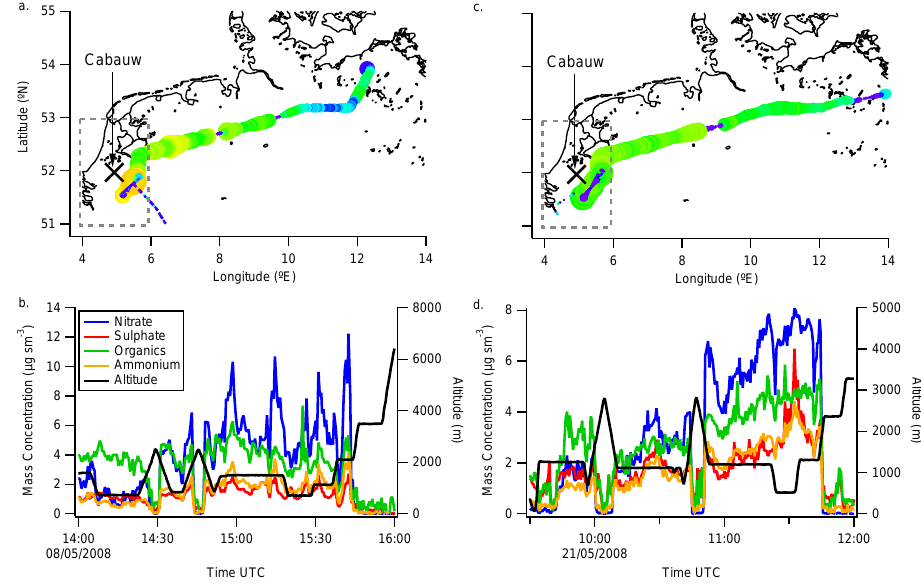
Fig. 5. Case study example of the distribution of aerosol chemical composition from B366 and B379. Panel (a) displays the B366 flight track coloured according to the nitrate mass fraction, while the markers are sized according to the AMS total mass concentration. The same colourscale and marker size is used as Fig. 4. Panel (b) shows the B366 AMS mass concentration time series and the altitude of the aircraft during the flight. Panel (c) shows the flight track for B379. Panel (d) shows the B379 AMS mass concentration time series and the altitude track of the BAe-146. The grey boxes in panels (a) and (c) mark out the boundaries of the defined proximity to Cabauw in the main text.